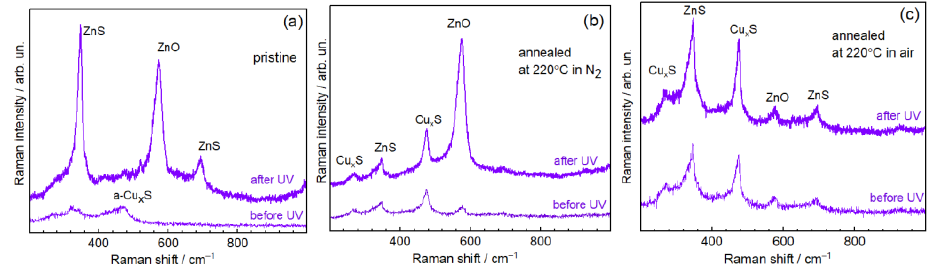
Figure 6. The effect of UV illumination on the Raman spectra of the CZTS NCs with the nominal content Cu 2 for the initial film ( a ) and films annealed in air ( b ) and in N 2 ( c ). The spectra measured with 0.1 mW of the λ exc = 325 nm before (bottom curves) and after (upper curves) illumination at 0.5 mW for 5 min.